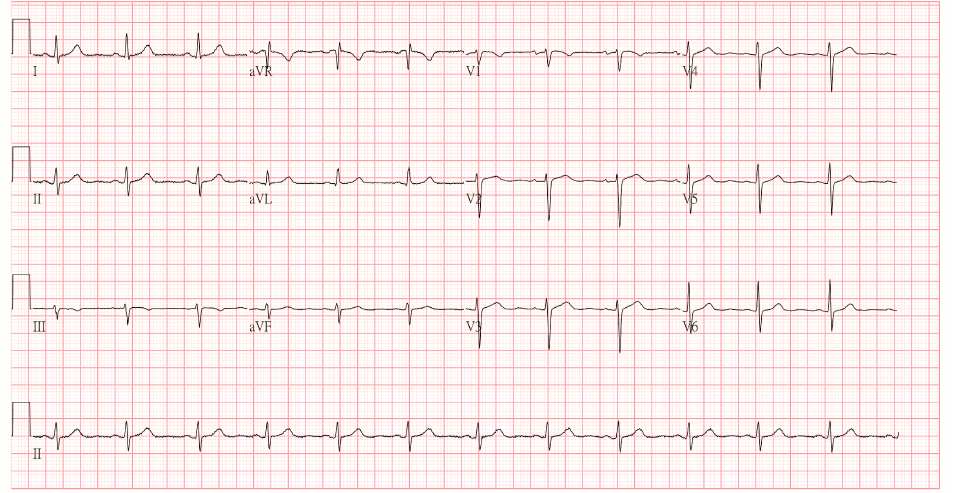
Figure 1. The initial electrocardiogram revealed normal sinus rhythm without any ST segmental elevation or depression.